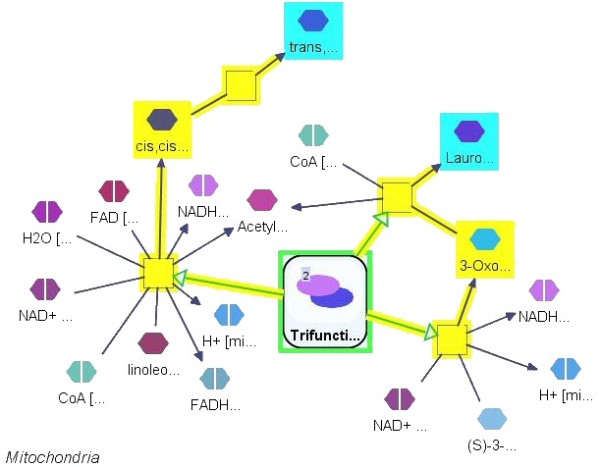
Common regulator. The common upstream, with a path limit of 2, of small molecules containing the word "lauro" in their name (cyan) in this partial mechanistic pathway turns out to be a single node representing a molecular complex (green). The paths from the potential common regulator to the target nodes are highlighted (yellow).